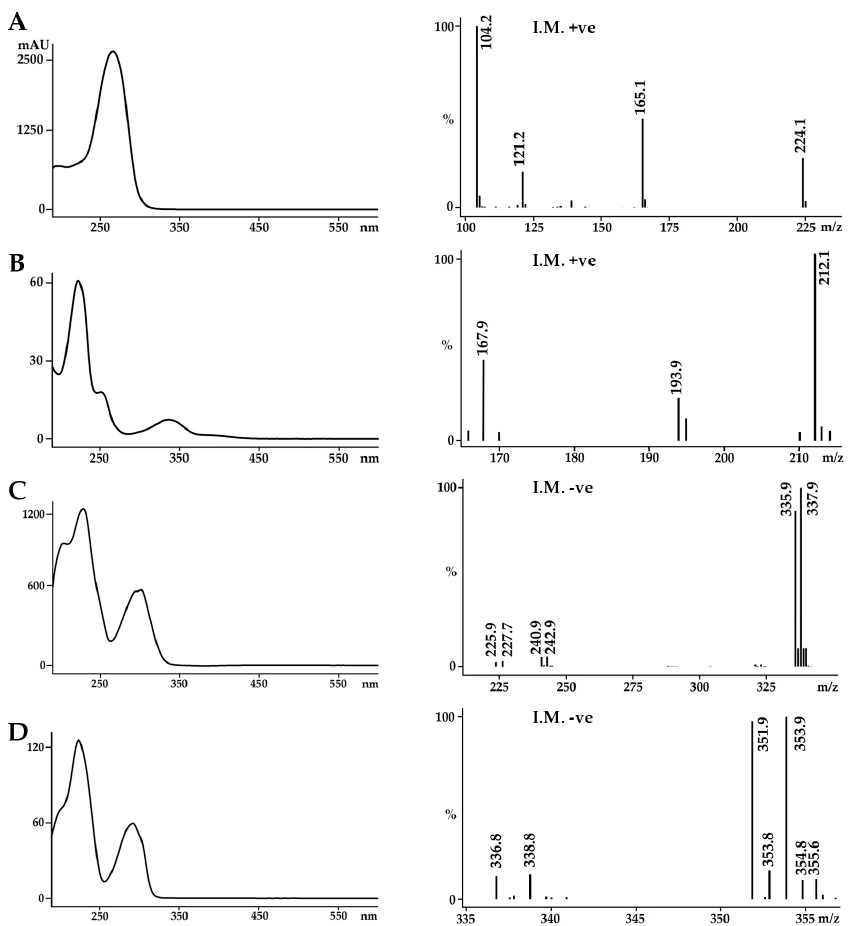
Figure 3. UV spectra (left), and mass spectra (right) for the ultimate precursors of Tyrian purple found in the hypobranchial gland of Dicathais orbita from high-performance liquid chromatography-mass spectrometry (HPLC-MS) with electrospray ionisation (ESI). The compounds are: ( A ) murexine ( 1 ); ( B ) indoxyl sulphate; ( C ) tyrindoxyl sulphate ( 2 ); and ( D ) tyrindoxyl S-oxide sulphate ( 3 ). I.M. ionisation mode: I.M. +ve = positive ions, I.M. − ve = negative ions. Table 1. 1 H-NMR assignment for murexine (CD 3 CN)) and tyrindoxyl sulphate (D 2 O) isolated from the hypobranchial gland extract of Dicathais orbita by HPLC preparative system.